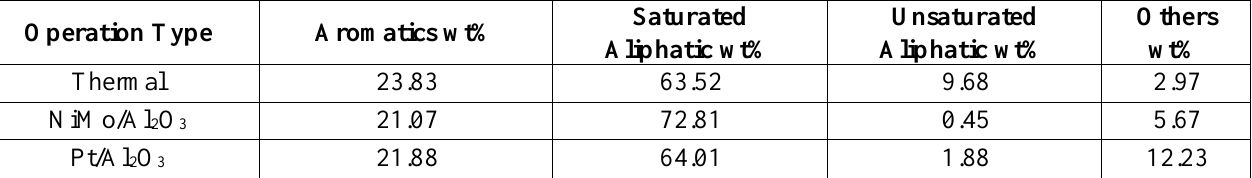
Figure 9: catalytic hydrocracking components over Pt/Al 2 O 3 catalyst. Table 2: The proportions of hydrocarbons product in the liquid